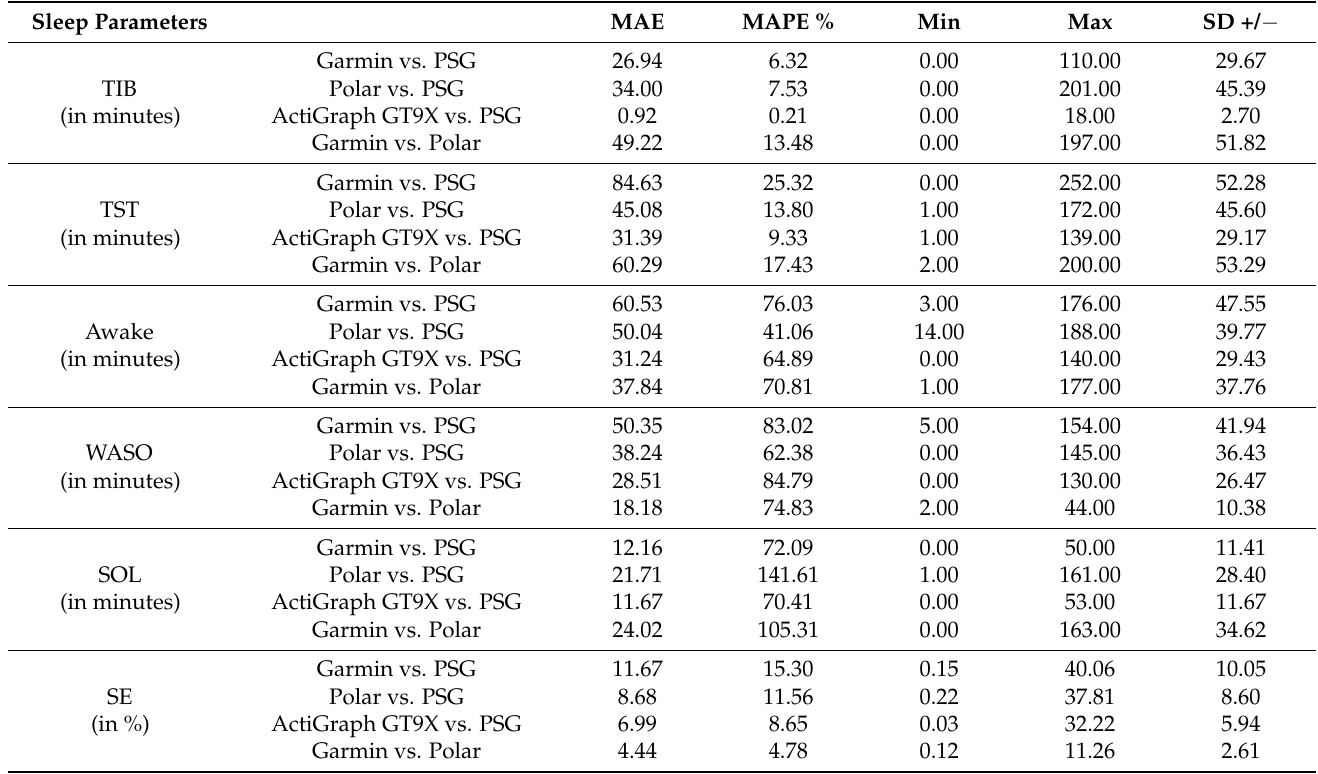
Table 3. Sleep parameters deviation calculation of mean absolute error (MAE) and mean absolute percentage error (MAPE) ( n =